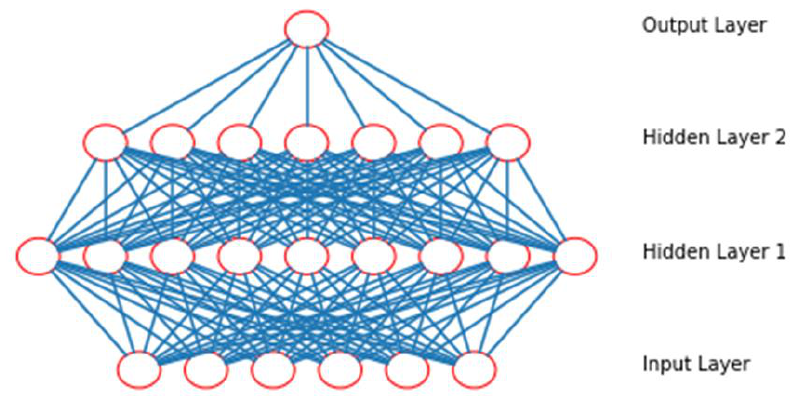
Figure 1. Architecture of the ANN.